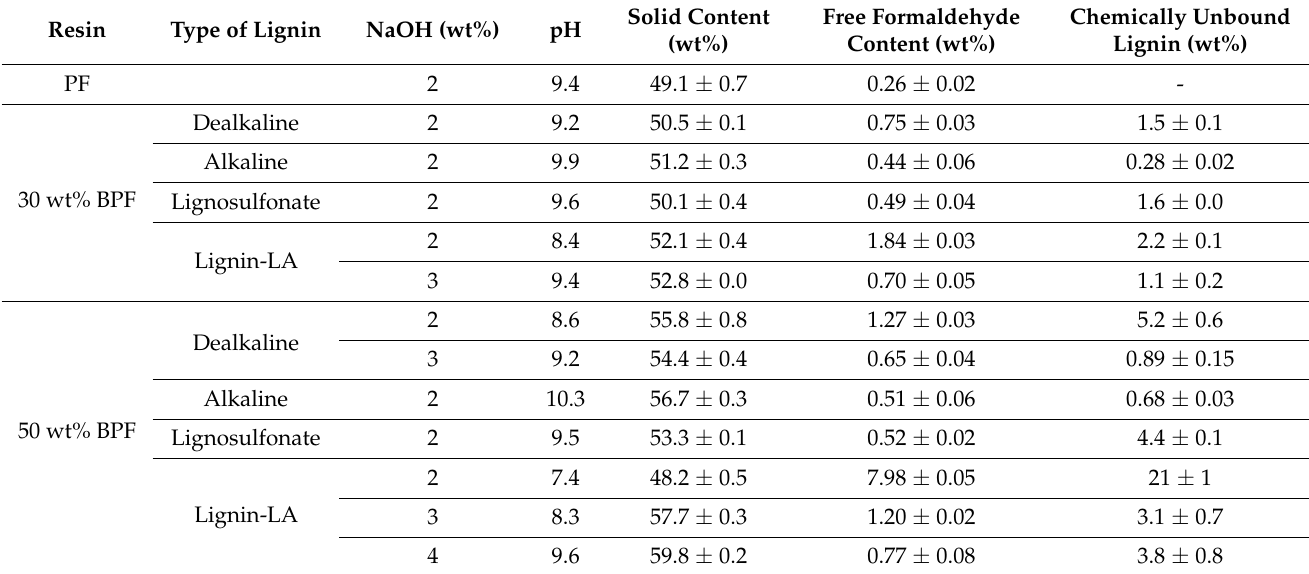
Table 1. Physicochemical properties of resole resins.